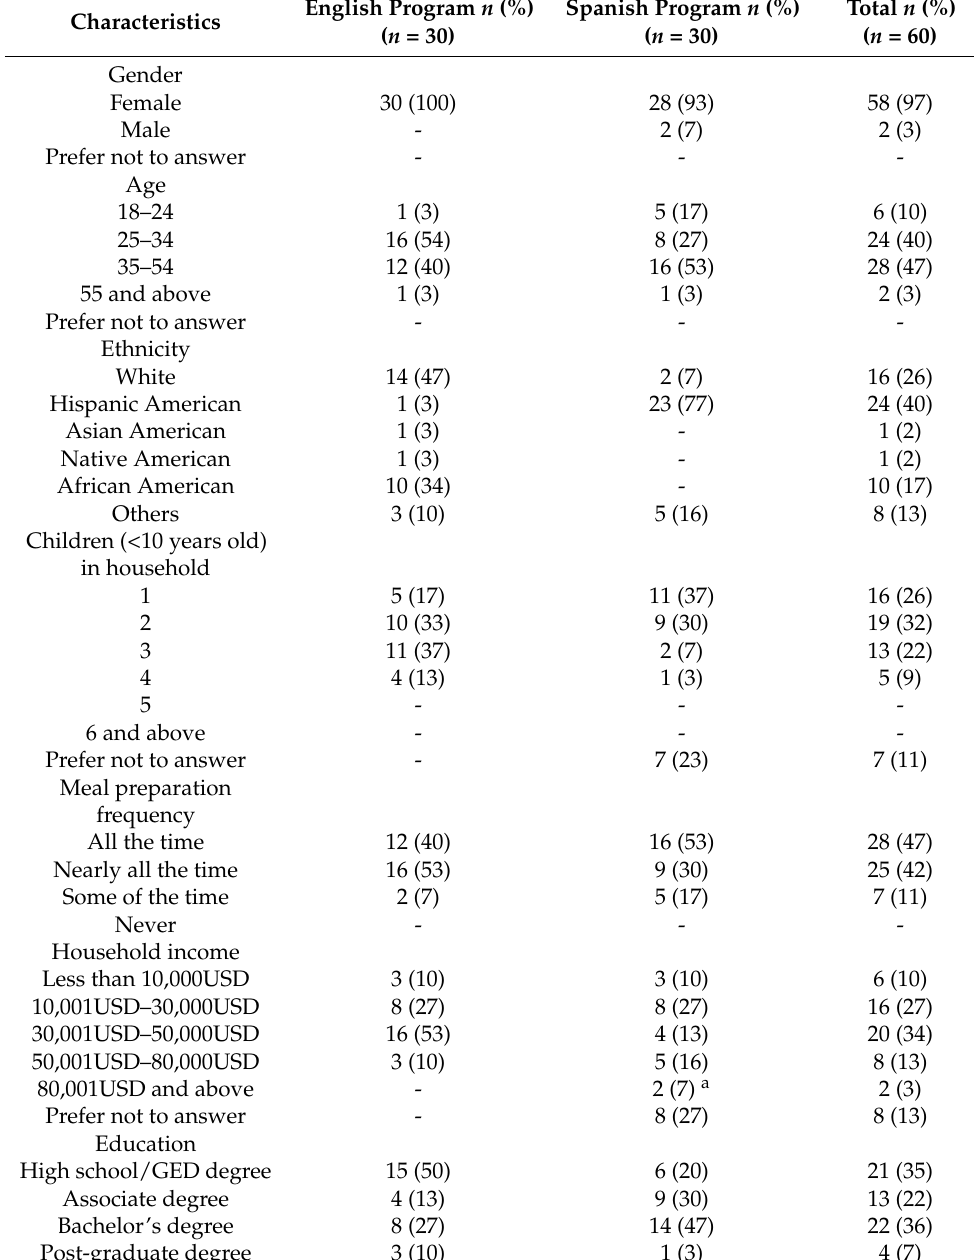
Table 2. Sociodemographic characteristics of the virtual food safety educational